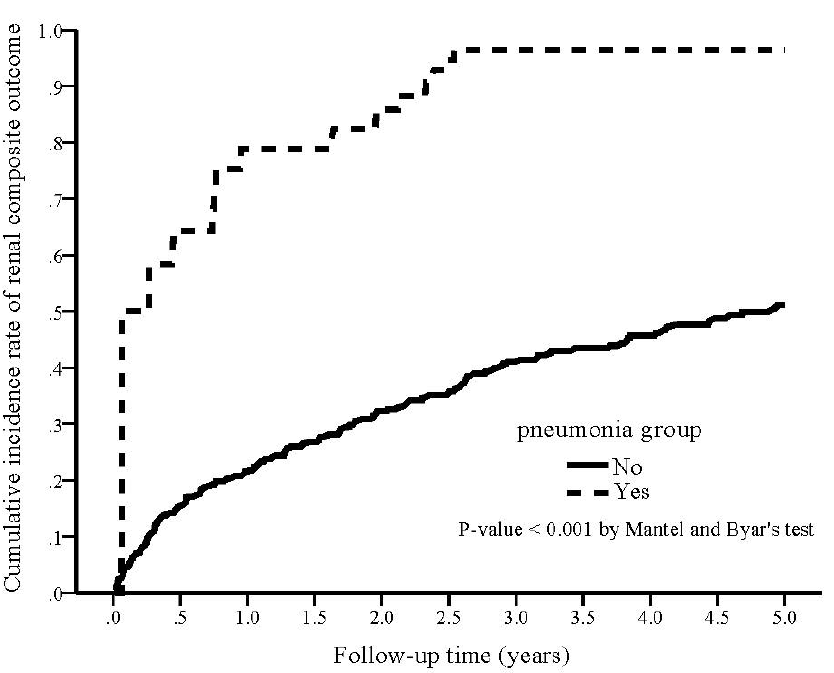
Figure 4. Kaplan–Meier curve of the cumulative incidence rate of renal composite outcome for patients with and without pneumonia (Mantel and Byar’s test, p < 0.001).